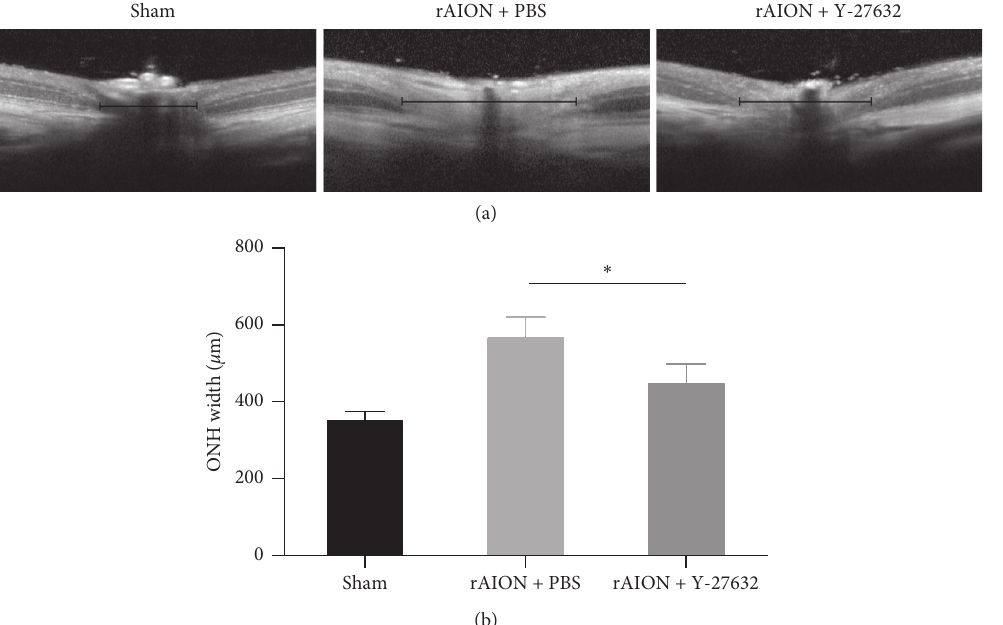
Figure 1: Cross-sectional OCT images of the ONH 2 days after induction. (a) Linear scan across the ONH. The black lines in the images identify the ONH width in each group. (b) Quantification of ONH width. The ONH width in the Y-27632-treated group was significantly reduced compared with the PBS-treated group (454.4 ± 51.2 μ m vs. 574.4 ± 53.6 μ m, p < 0 . 05, n � 12 per group). The asterisk indicates p < 0 . 05, as determined by the Kruskal–Wallis